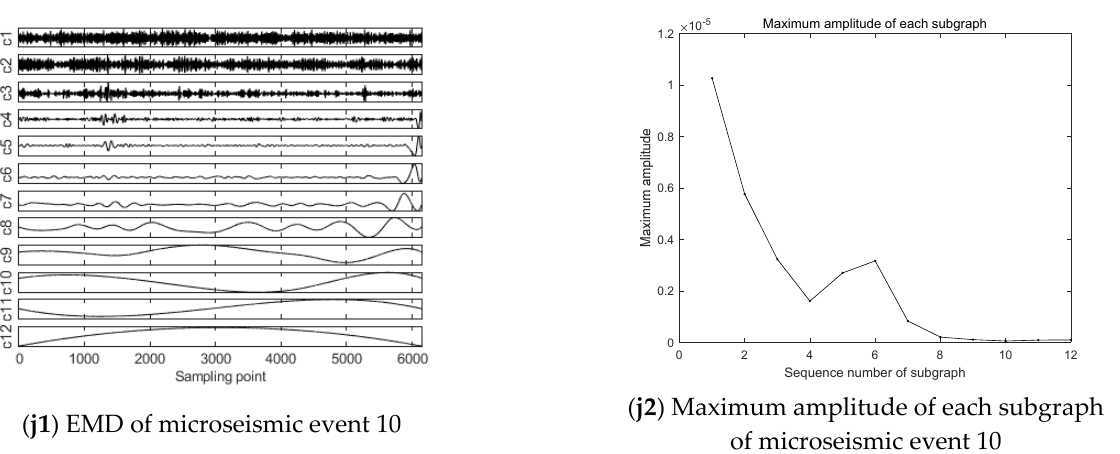
Figure 7. EMD and maximum amplitude of each subgraph.